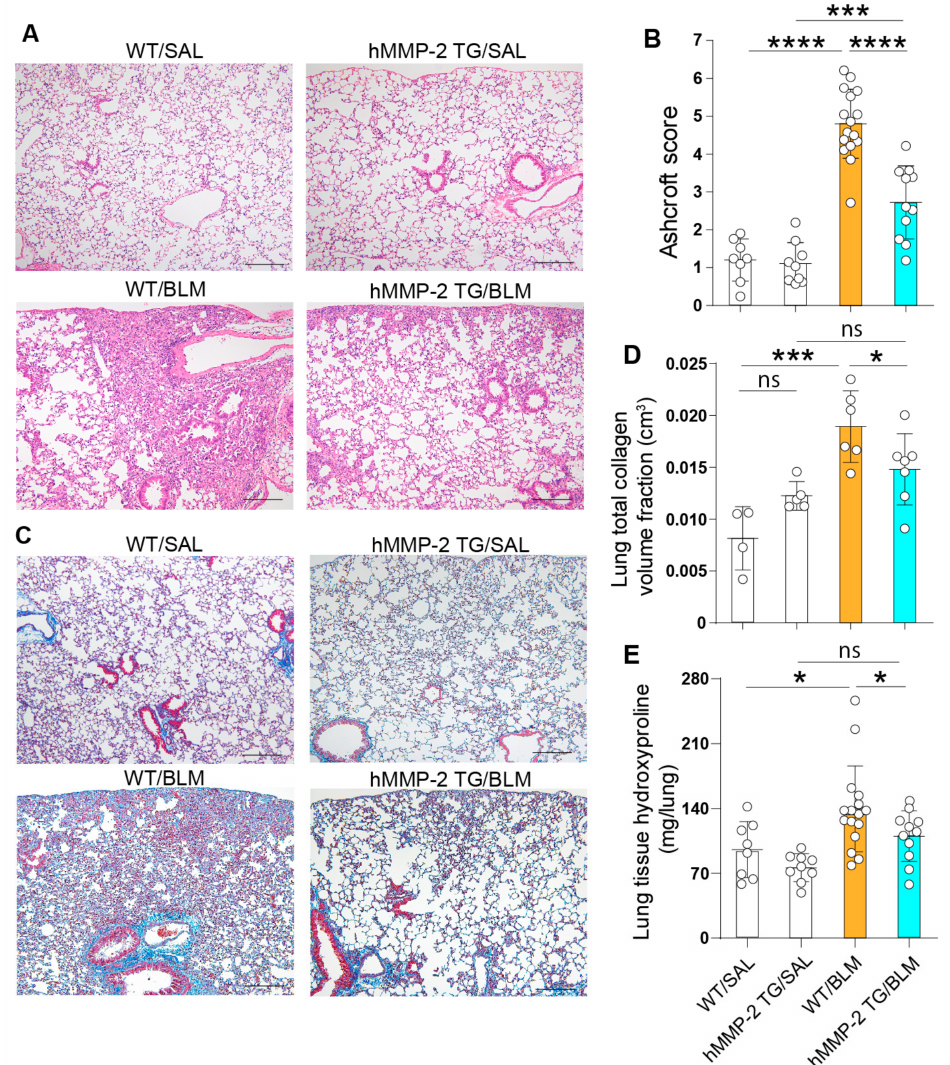
Figure 6. Amelioration of histopathological and biochemical findings of pulmonary fibrosis in hMMP-2 TG mice. Ashcroft scoring was performed in lung tissue stained with hematoxylin & eosin by blinded experts for the treatment groups ( A , B ). Collagen deposition was evaluated after trichrome staining, and the total lung collagen volume fraction was calculated ( C , D ). The lung tissue hydrox- yproline content was measured by a colorimetric assay ( E ). Scale bars indicate 200 µ m. The number of mice in ( A – C , E ): n = 8 in WT/SAL, n = 9 in hMMP-2 TG/SAL, n = 16 in WT/BLM, and n = 11 in hMMP-2 TG/BLM. Data are the mean ± S.D. The number of mice in D: n = 4 in WT/SAL, n = 5 in hMMP-2 TG/SAL, n = 6 in WT/BLM, and n = 7 in hMMP-2 TG/BLM. All mice were female.